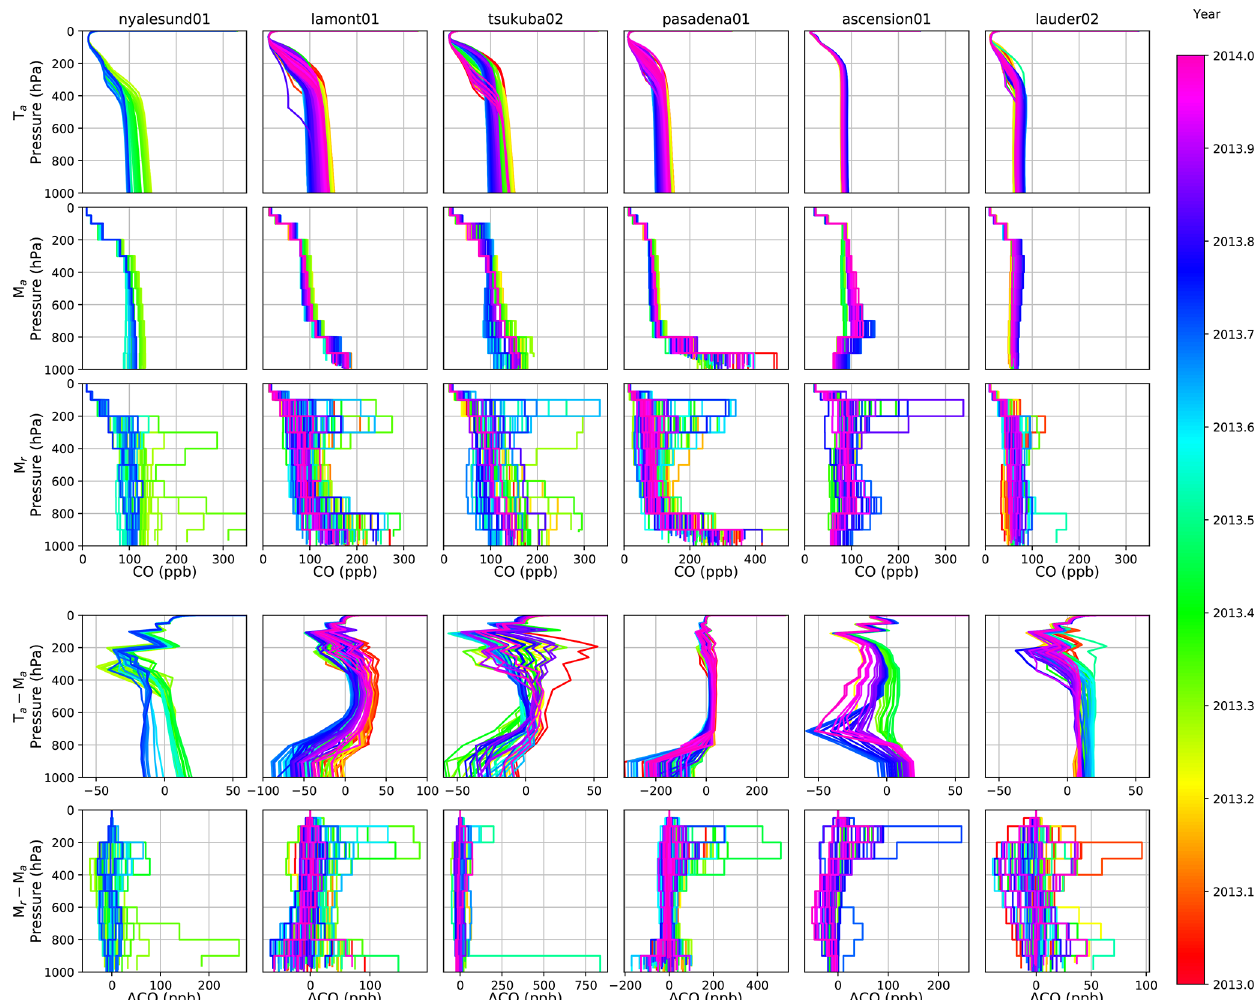
Figure D1. Profiles and profile differences between MOPITT and TCCON for six select sites and different days in 2013. For clarity, only one MOPITT profile within the coincidence criteria is selected per day. The rows are the TCCON a priori profiles ( T a ), the MOPITT a priori profiles ( M a ), the MOPITT retrieved profiles ( M r ), the difference between TCCON and MOPITT a priori profiles, and the difference between MOPITT a priori and retrieved